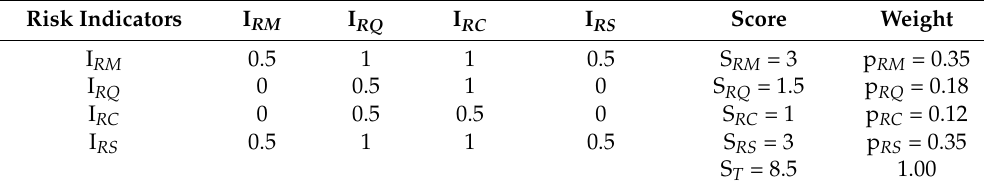
Table 10. Environmental risk performance indicators.